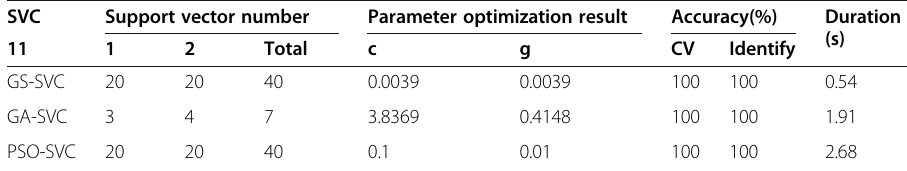
Table 6 Two-classification pattern training and recognition results SVC Support vector number